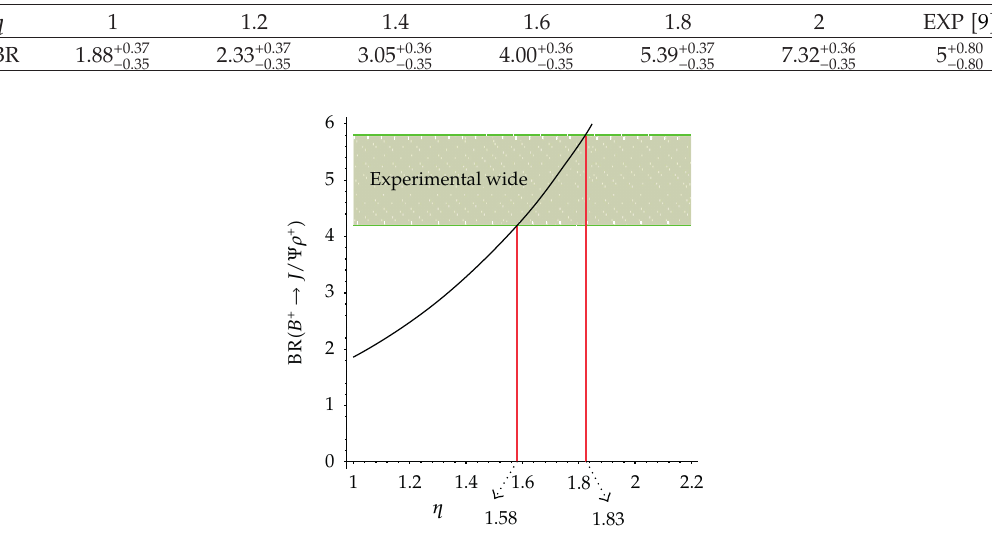
Figure 5: The variation of the branching ratio of B (cid:2) → J/ψρ (cid:2) with η (cid:6) 1 ∼ 2 .